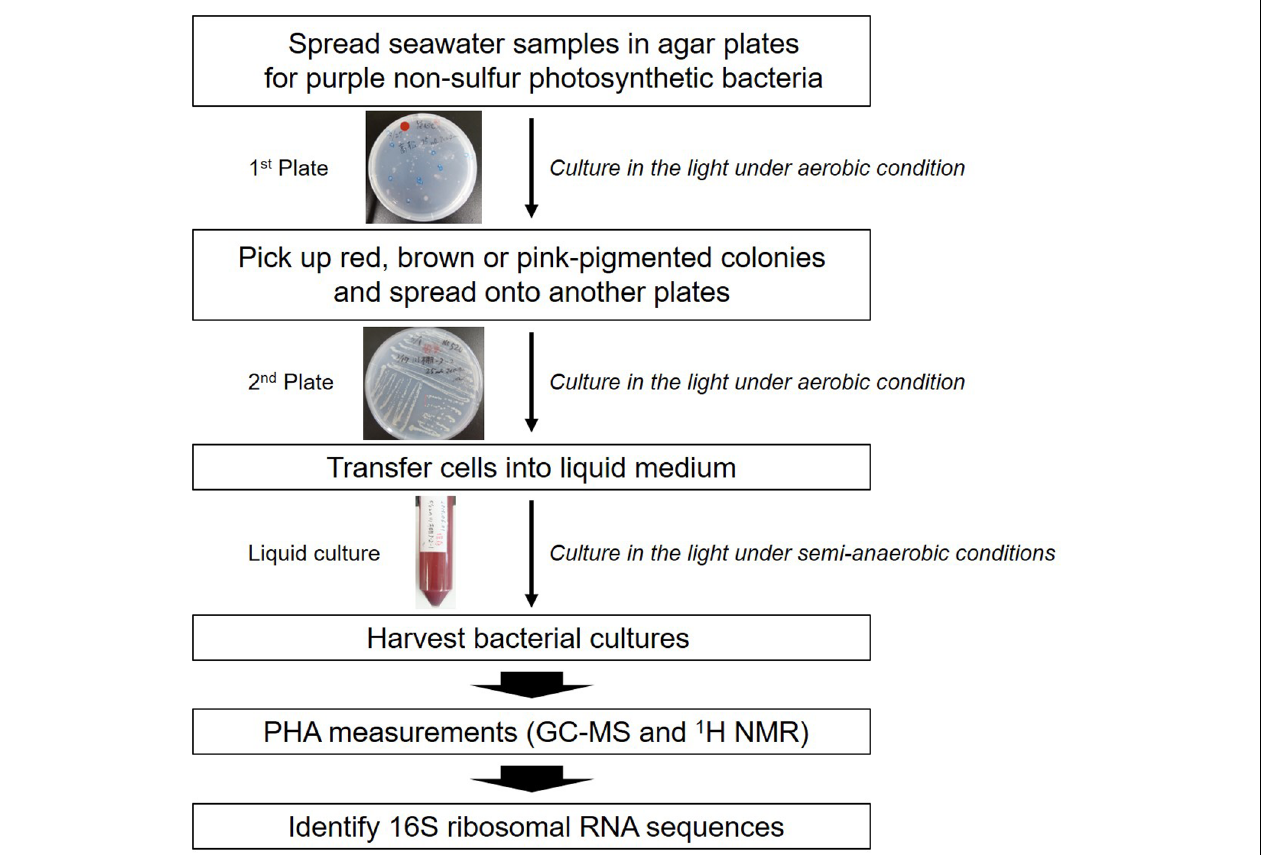
FIGURE 1 | Isolation scheme for PHA-producing purple non-sulfur photosynthetic bacteria.